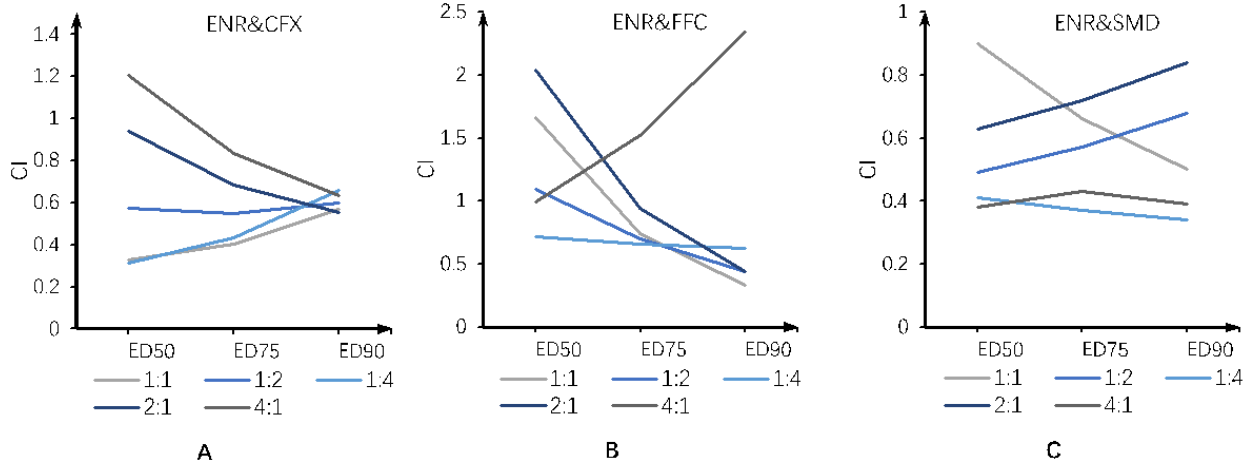
Figure 3. Comparison of CI values of binary combination enrofloxacin and ciprofloxacin ( A ), en- rofloxacin and florfenicol ( B ), and enrofloxacin and sulfamethazine ( C ) at different mixing ratios.